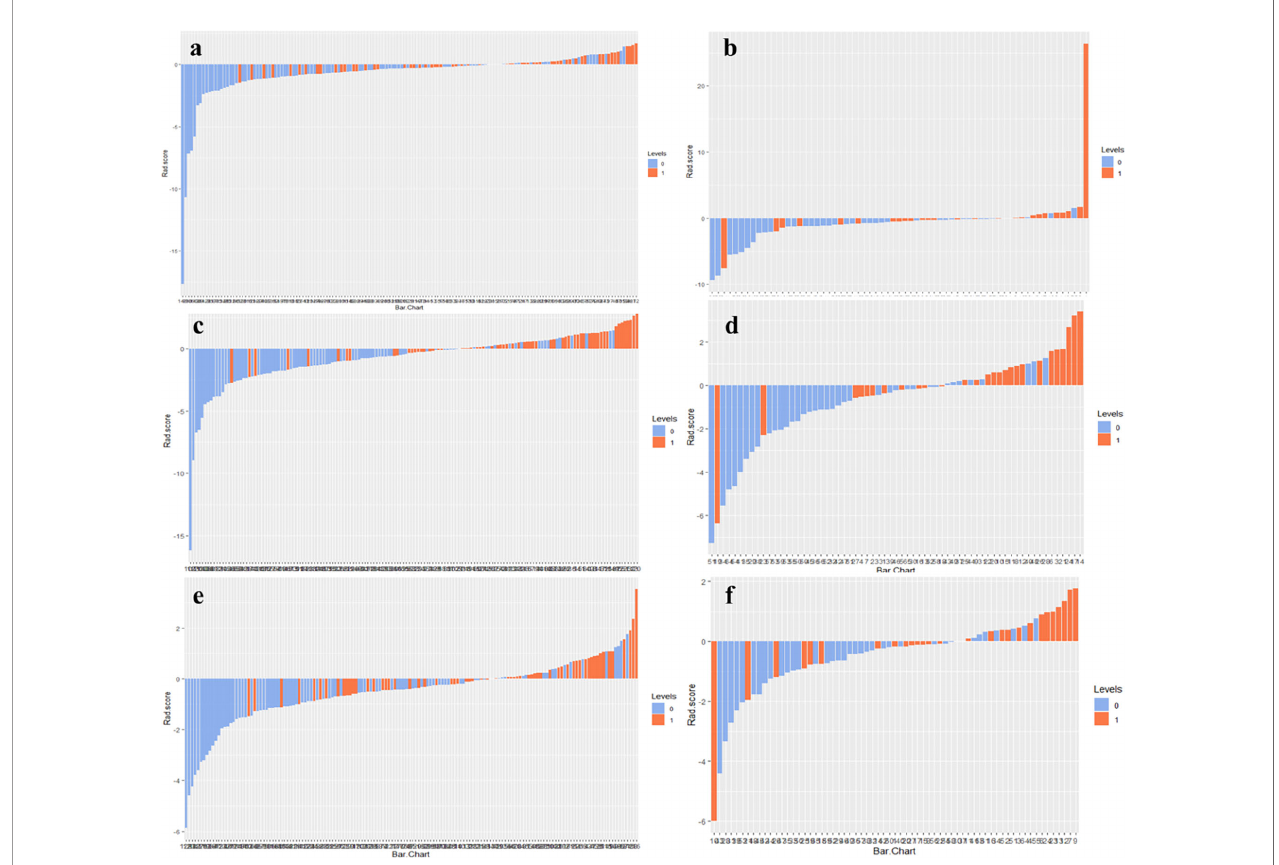
FIGURE 4 | Radiomics score bar diagrams of RS1, RS2, and Delta RS in the training (A, C, E) and validation sets (B, D, F) were plotted. Up and down bars refer to the predicted NAC responding and NAC non-responding lesions, respectively. Blue and red bars refer to actual NAC responding and NAC non- responding lesions, respectively.